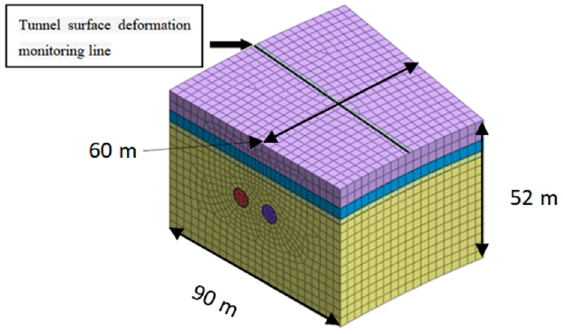
Figure 3. Numerical model of small radius curve tunnel.